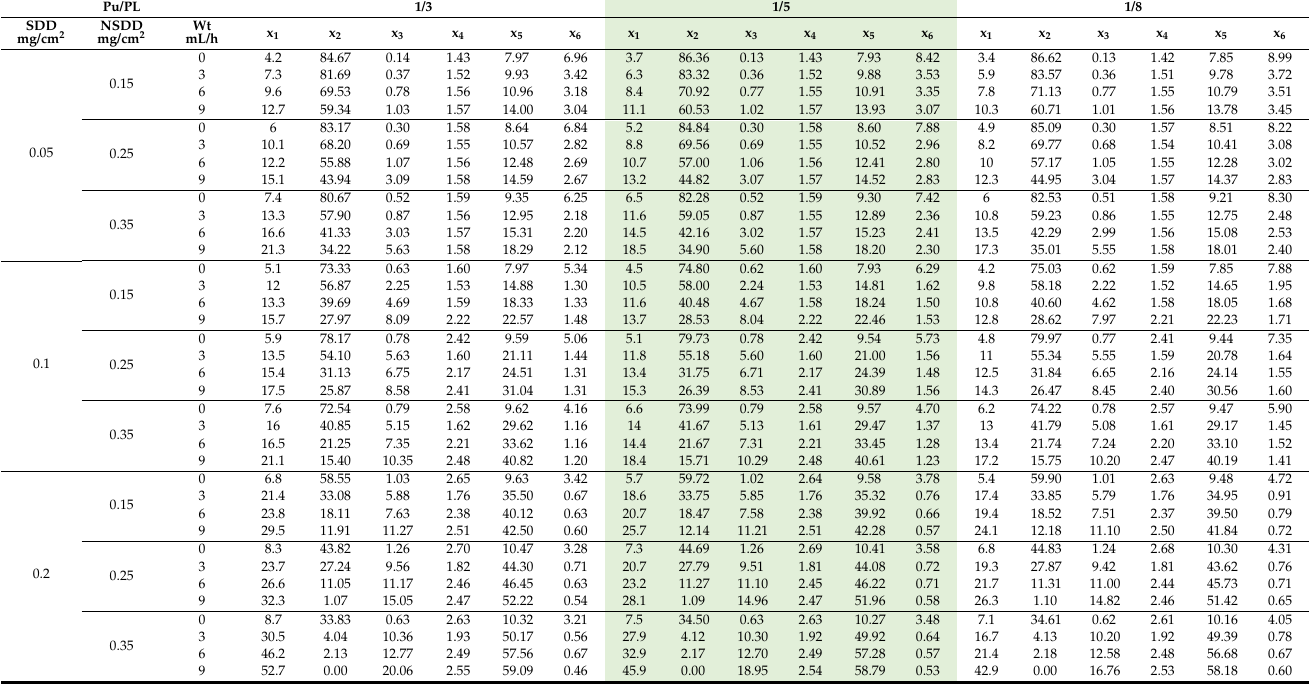
Table 4. LC indices of nonuniformly polluted insulators under different Wt and NSDD for 11 kV insulators.